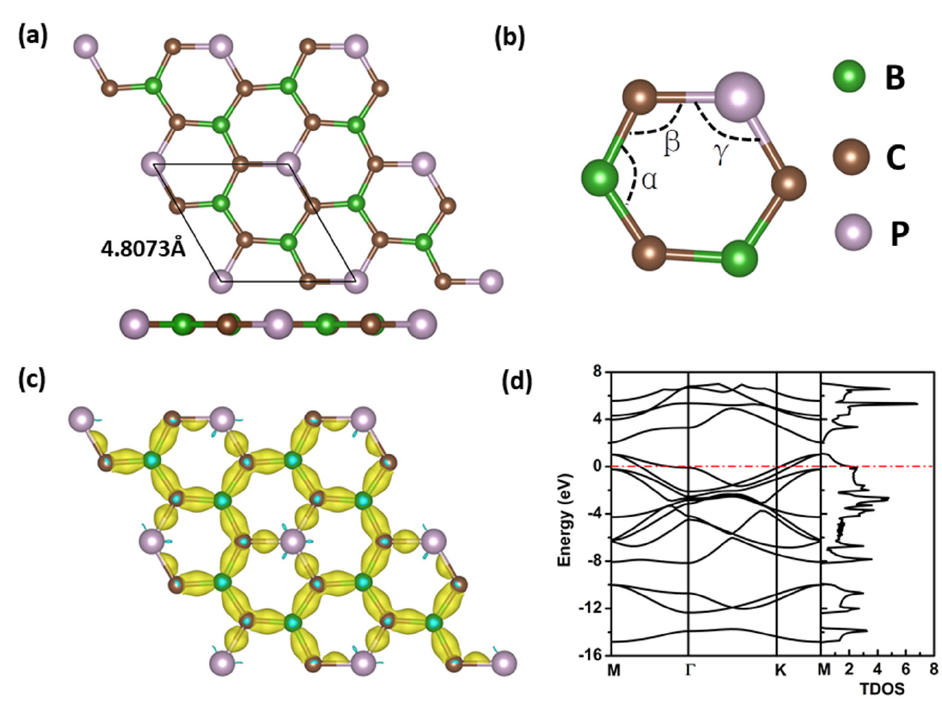
Figure 1. ( a ) Top and side view illustration of B 2 C 3 P, and the solid line frame represents the unit cell of B 2 C 3 P. ( b ) B 2 C 3 P hexagonal geometry. B, C and P atoms are colored green, brown, and grey, respectively. ( c ) Charge density difference of B 2 C 3 P. The gold color (i.e., 0.025 eÅ − 3 ) means a charge density increase, while the cyan color (i.e., 0.025 eÅ − 3 ) means a charge density decrease. ( d ) Electronic band structure and total density of states of B 2 C 3 P.